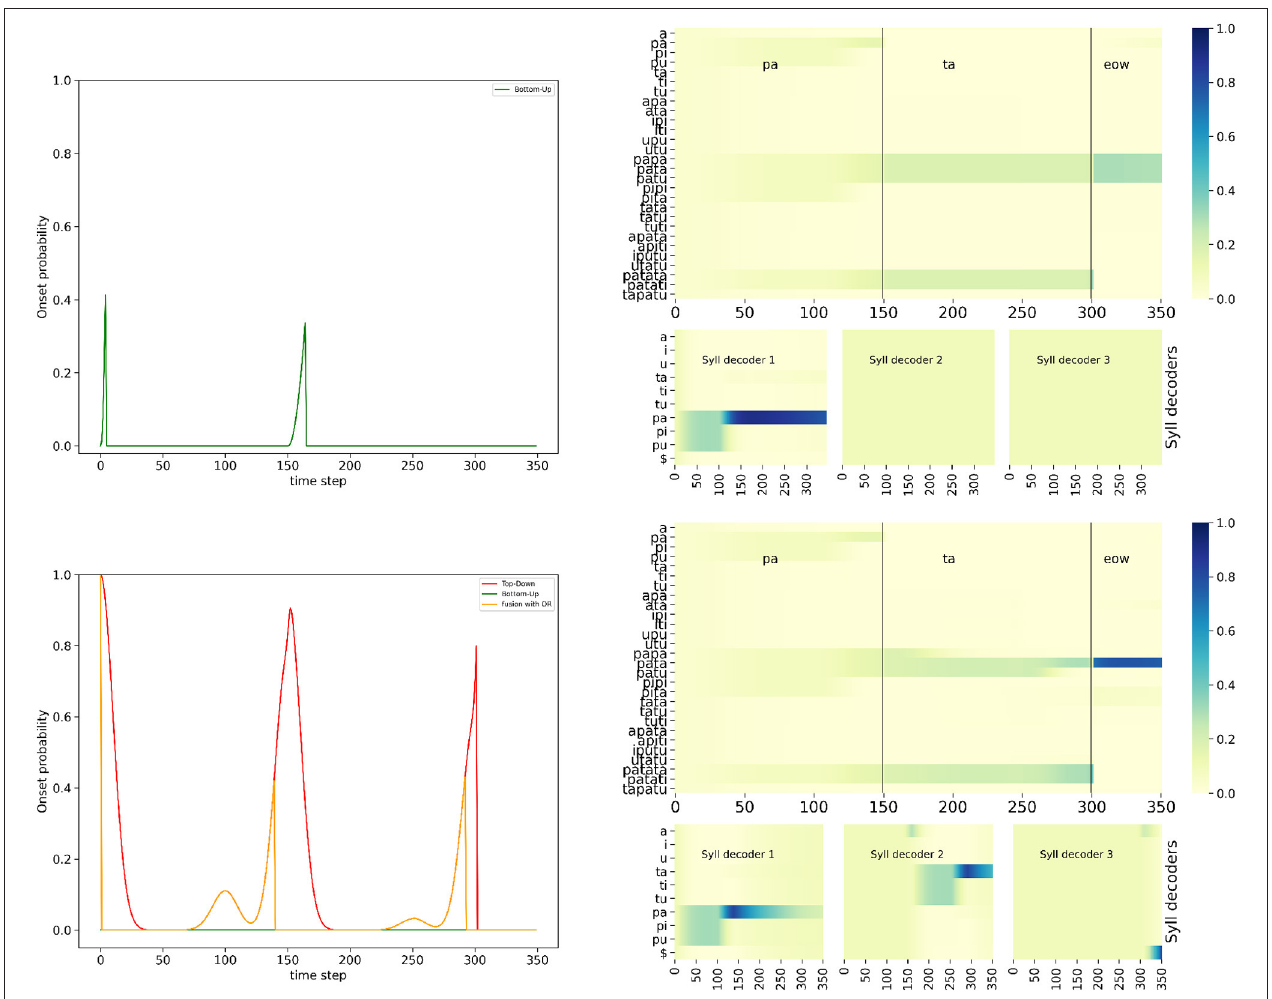
FIGURE 9 | Example of simulation of the “BU-only” variant (top row) and the full model, with the OR fusion model (bottom row) , in the hypo-articulation-event condition, on input word “pata.” Graphical content is presented in the same manner as in Figure 7 .